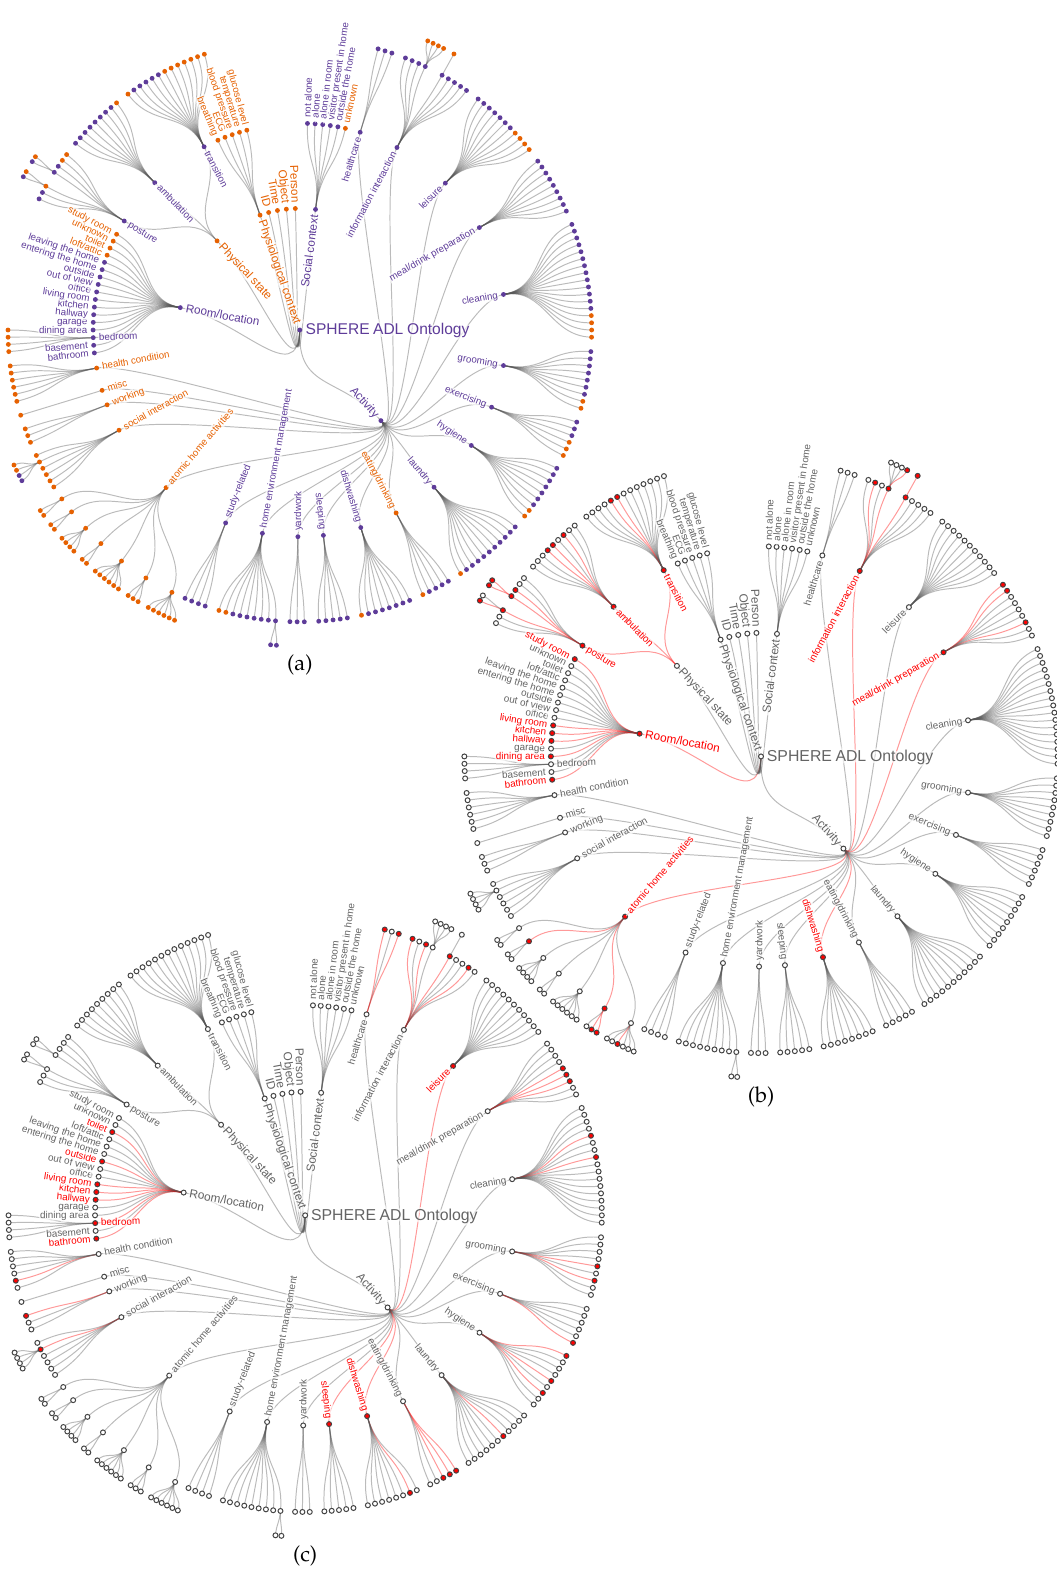
Figure 3. SPHERE ontology terms mapped to the Boxlab taxonomy and to two case studies. ( a ) SPHERE ontology (orange) alignment with BoxLab (purple). ( b ) SPHERE ADL terms used in post-hoc video annotation. ( c ) SPHERE ADL terms used in self-annotation condition (terms used for this purpose are highlighted in